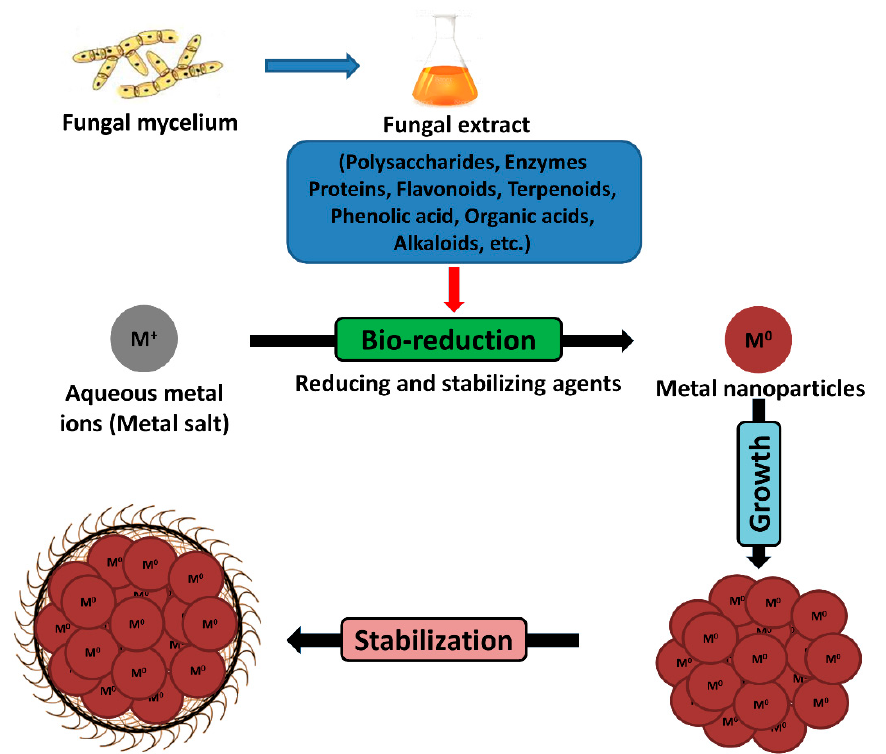
Figure 3. General mechanism involved in the synthesis, growth, and stabilization of metal nanoparticles using fungus.